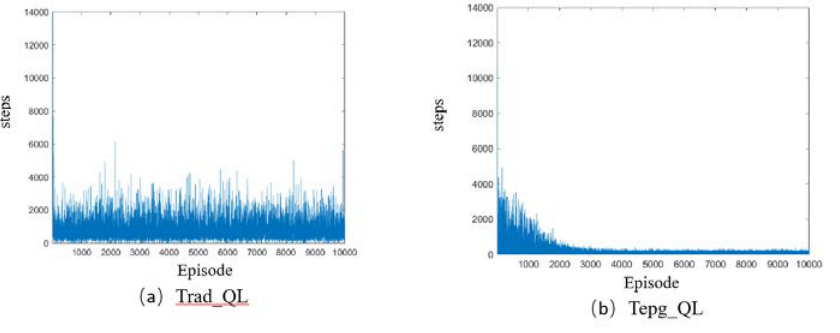
Fig. 3. Convergence Iterative Curves of Two Algorithms.